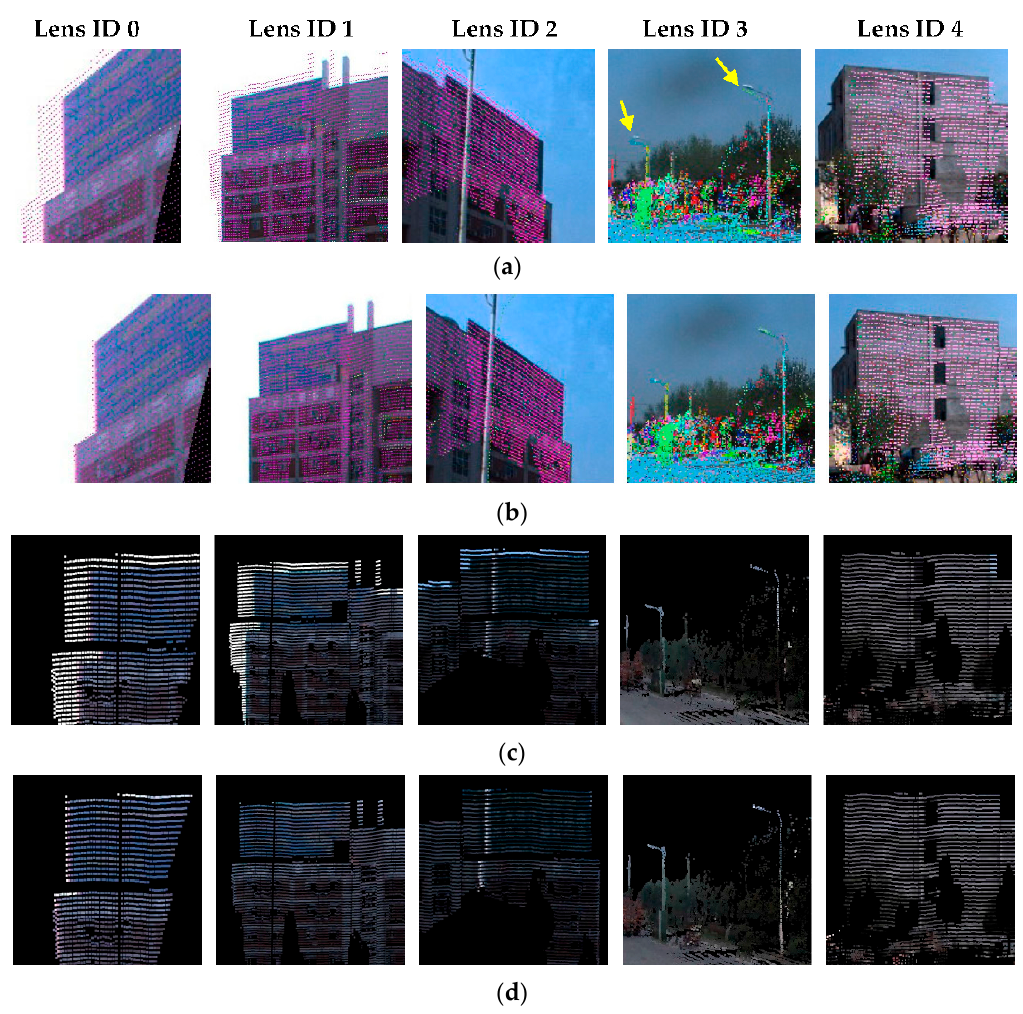
Figure 11. Alignments of two datasets before and after registration based on the panoramic camera model with lens id 0–4. ( a , b ) are the LiDAR points projected to a panoramic image before and after registration respectively; ( c , d ) are the 3d point cloud rendered by the corresponding panoramic image pixels respectively.